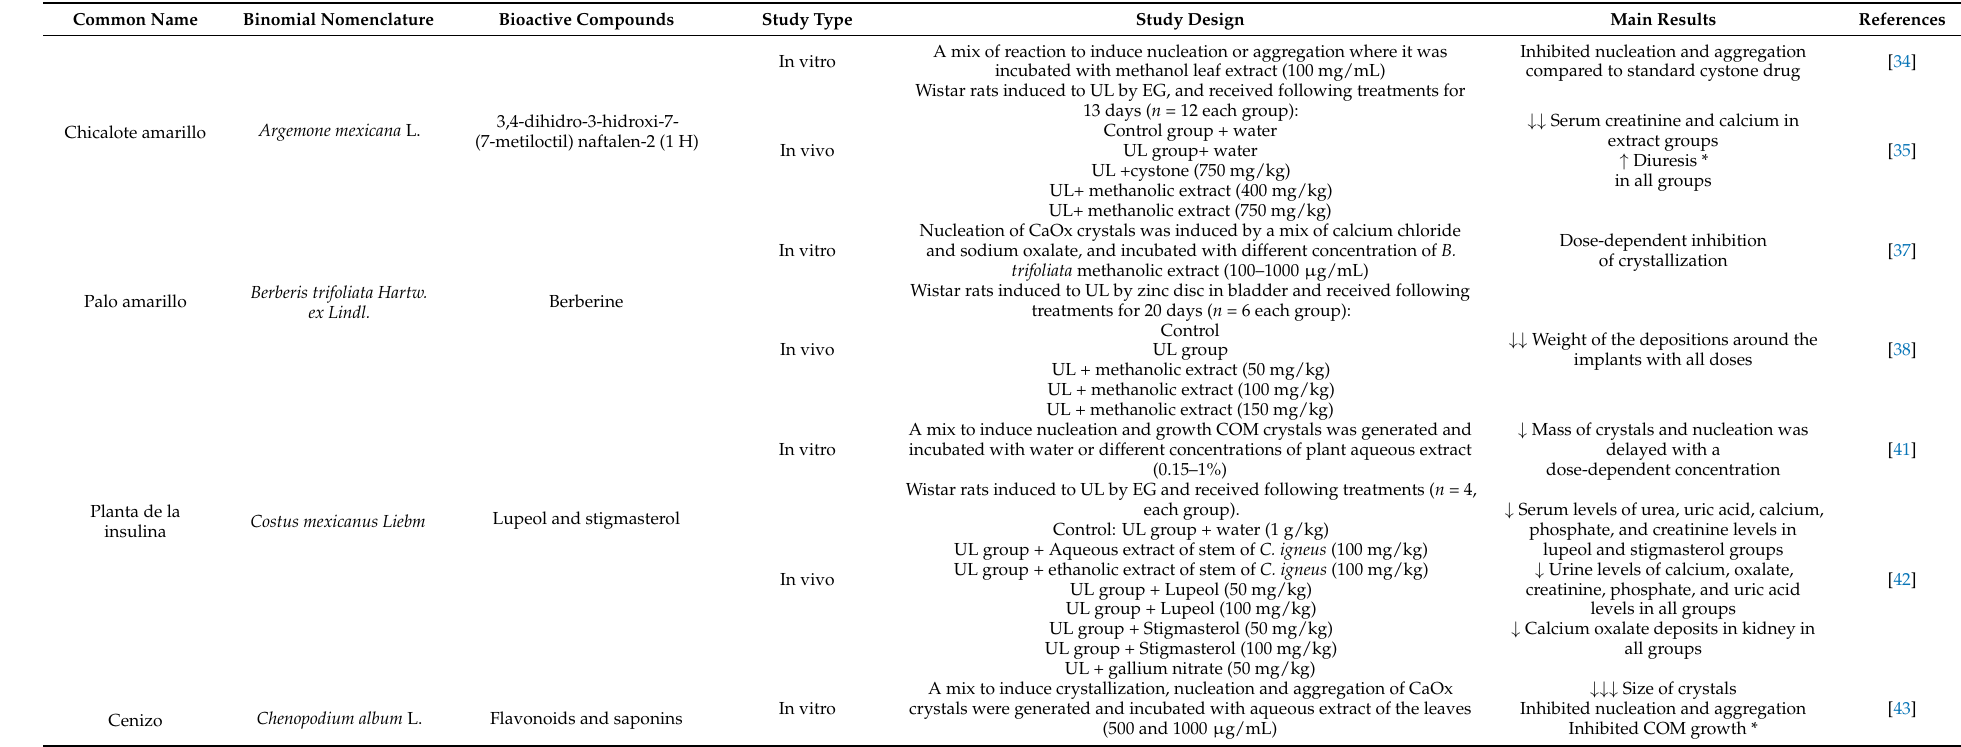
Table 1. Experimental evidence on plants used in Mexican traditional medicine used for prevention and treatment of